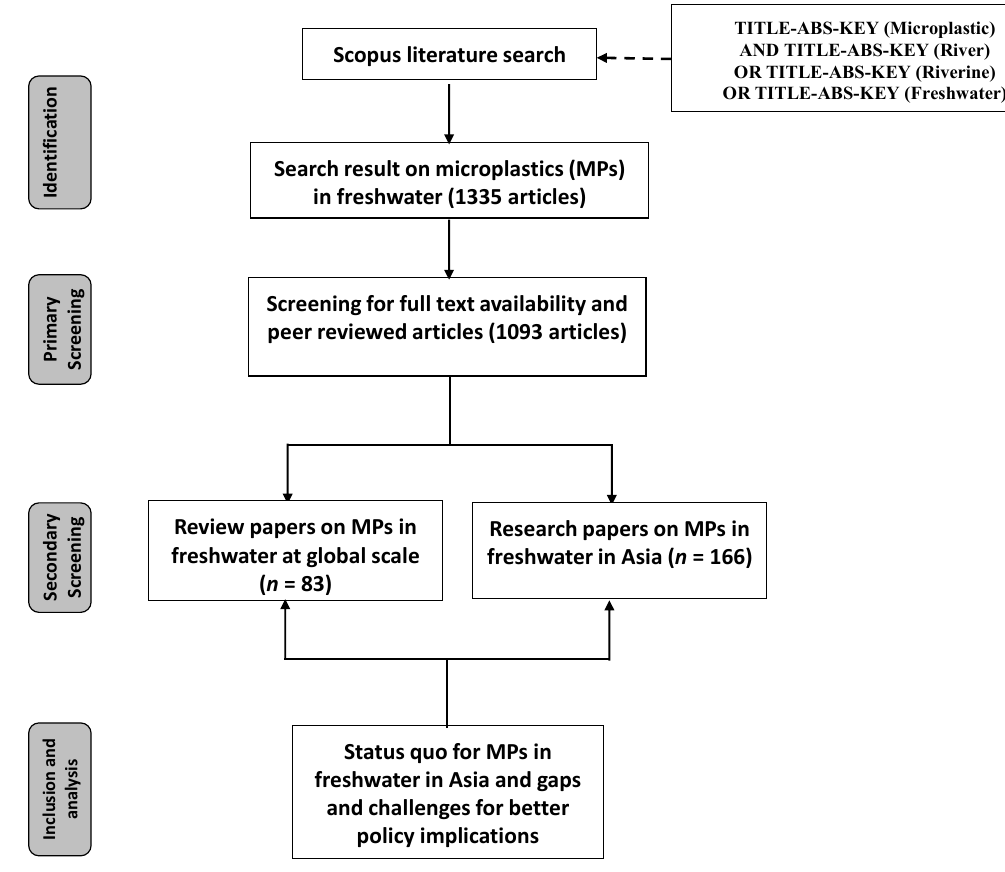
Figure 1. PRISMA flowchart of literature review work.